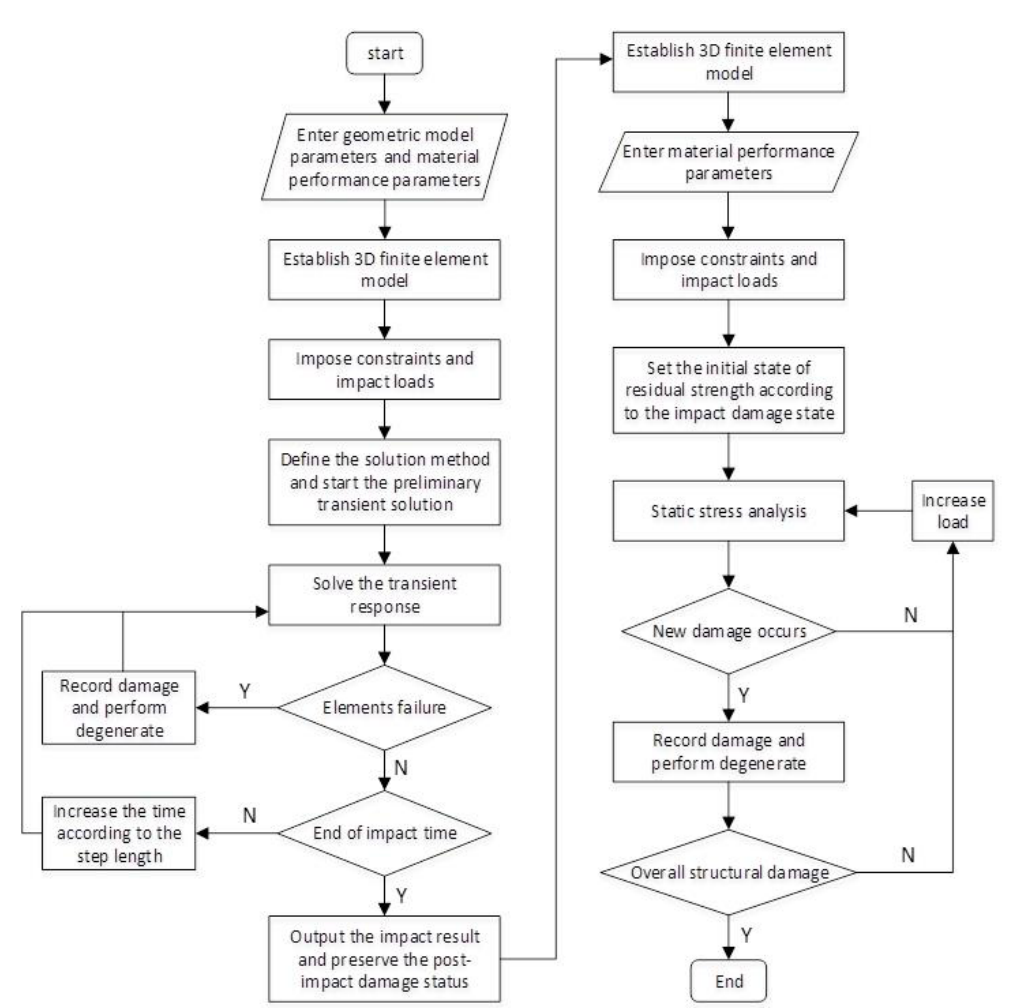
Figure 3. Simulation procedures of full-process analyzing method.